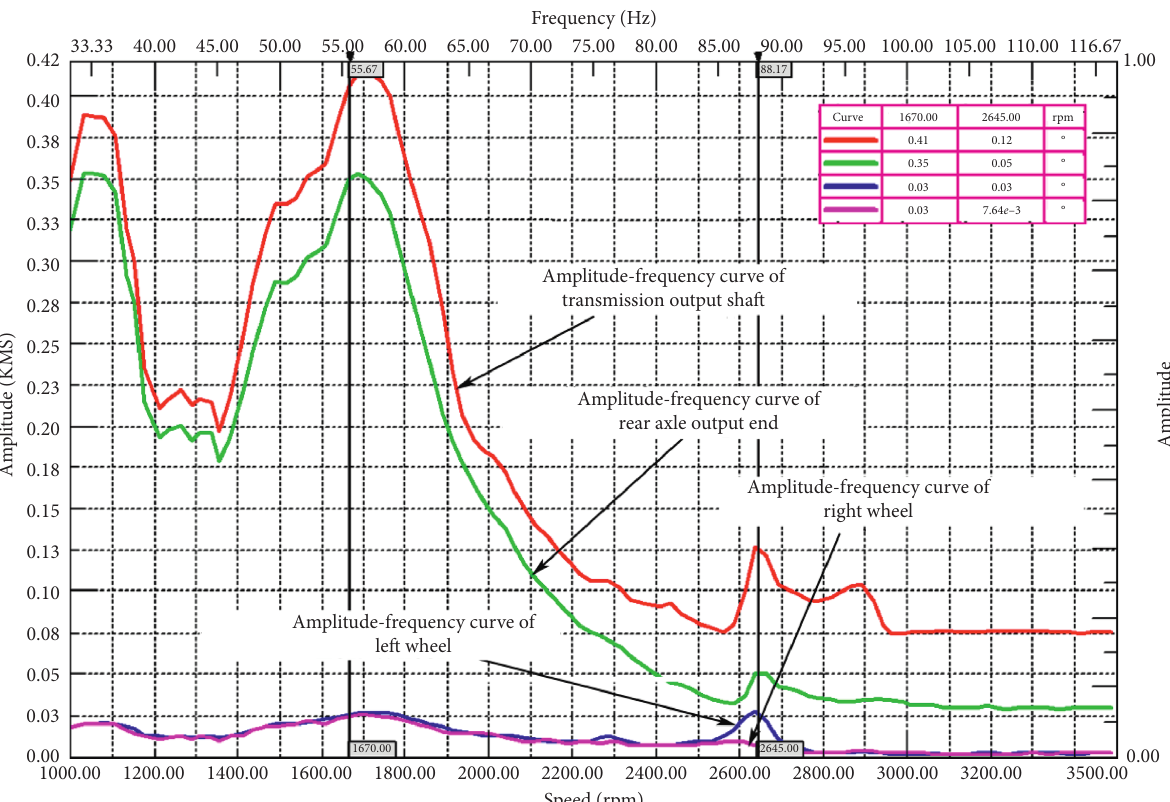
Figure 10: Amplitude-frequency responses of torsional vibration for powertrain at a torque fluctuation of 100N ·